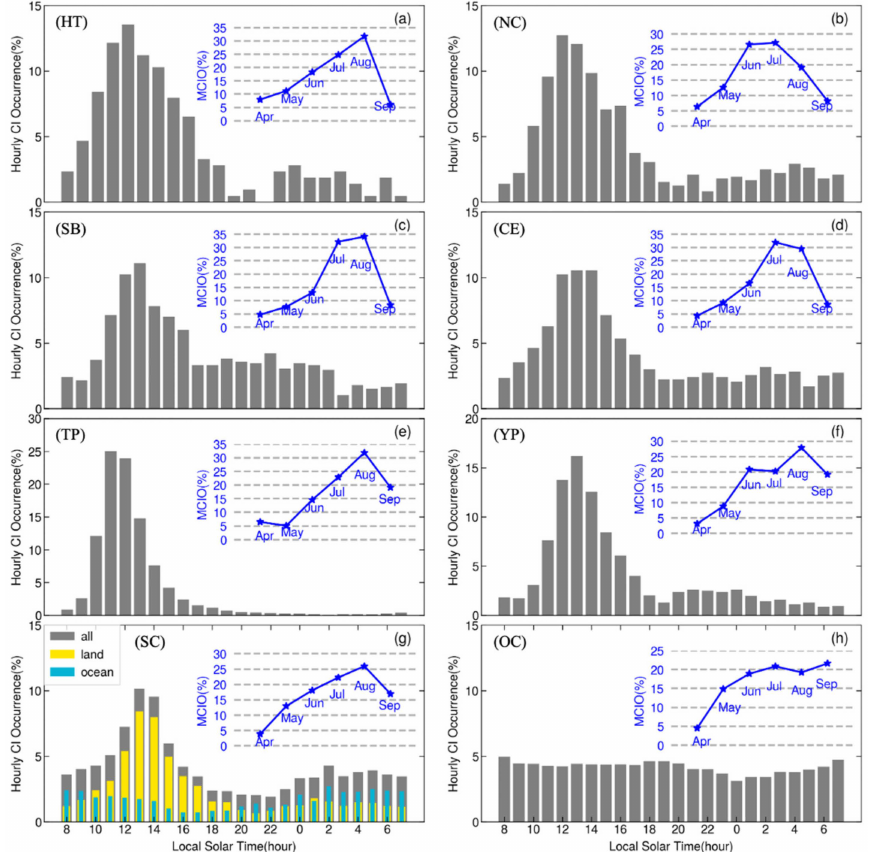
Figure 8. Monthly and hourly variability of DCSI occurrences over ( a ) Hetao (HT), ( b ) North China (NC), ( c ) Sichuan Basin (SB), ( d ) Central Eastern China (CE), ( e ) Tibetan Plateau (TP), ( f ) Yunnan- Guizhou Plateau (YP), ( g ) South China (SC) and ( h ) Oceans (OC). The legend land and ocean represent that the convective systems over land and ocean in South China, respectively. The legend all means that the all of convective systems in South China. MCIO stands for Monthly DCSI